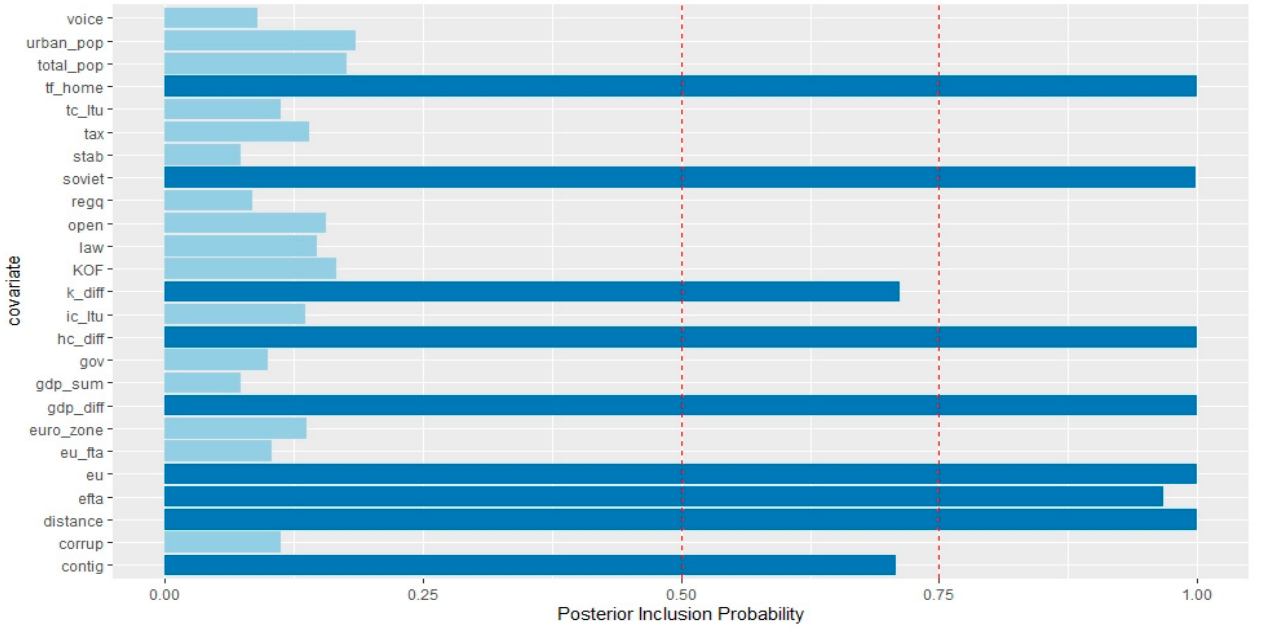
Figure 6. Inclusion probabilities for each of the potential covariates for Lithuania, restricted case (2004–2017).